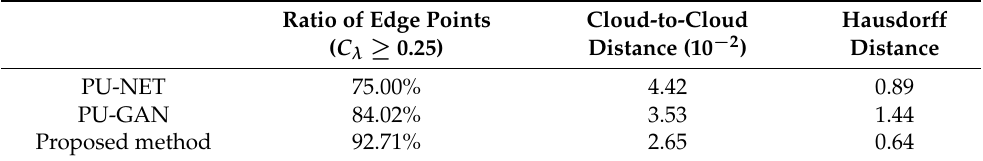
Figure 15. Frequency distribution of the point number with respect to the feature value (change- of-curvature (cid:1829) (cid:3090) ) for the initially extracted edge points and the upsampled edge points by using the three networks. Table 5. Quantitative comparisons of the upsampling networks. Table 5. Quantitative comparisons of the upsampling networks.